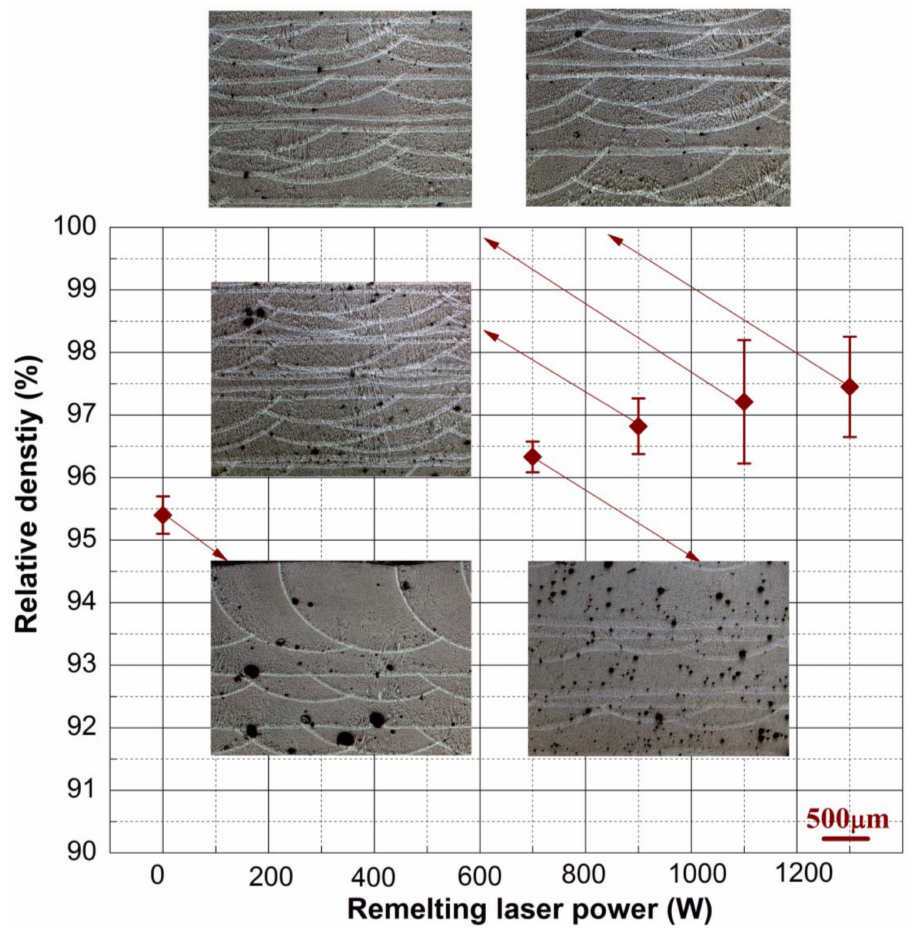
Figure 3. Optical images of the XZ section and curve of relative density versus remelting laser powers.